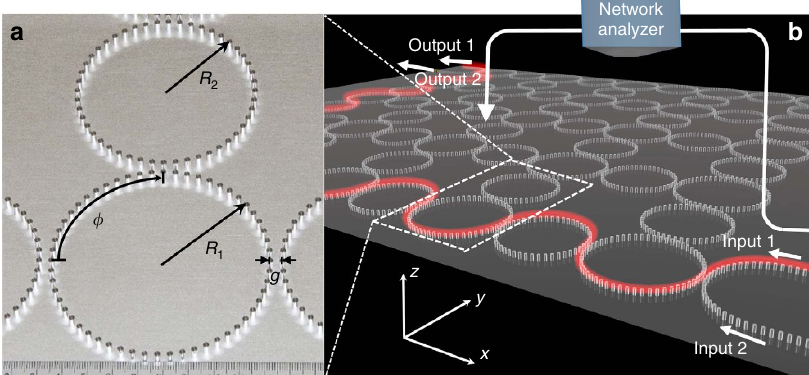
Figure 1 | Construction of a topological designer surface plasmon structure. ( a ) Photo of metallic rods with diameter 2.5mm and height 5.0mm distributed with center–center distance 5.0mm on a flat metallic surface. A lattice ring formed by 56 metallic rods is with radius R 1 ¼ 44.56mm. A coupling ring formed by 48 metallic rods is with radius R 2 ¼ 38.2mm. The ring–ring distance is g ¼ 5.0mm. f denotes the phase delay of electromagnetic waves along a quarter of a lattice ring. ( b ) Schematic of a 5 (cid:4) 5 lattice in experiment. A network analyser records the field pattern by scanning a near-field probe above the metallic rods. The red meandering curve above the structure represents